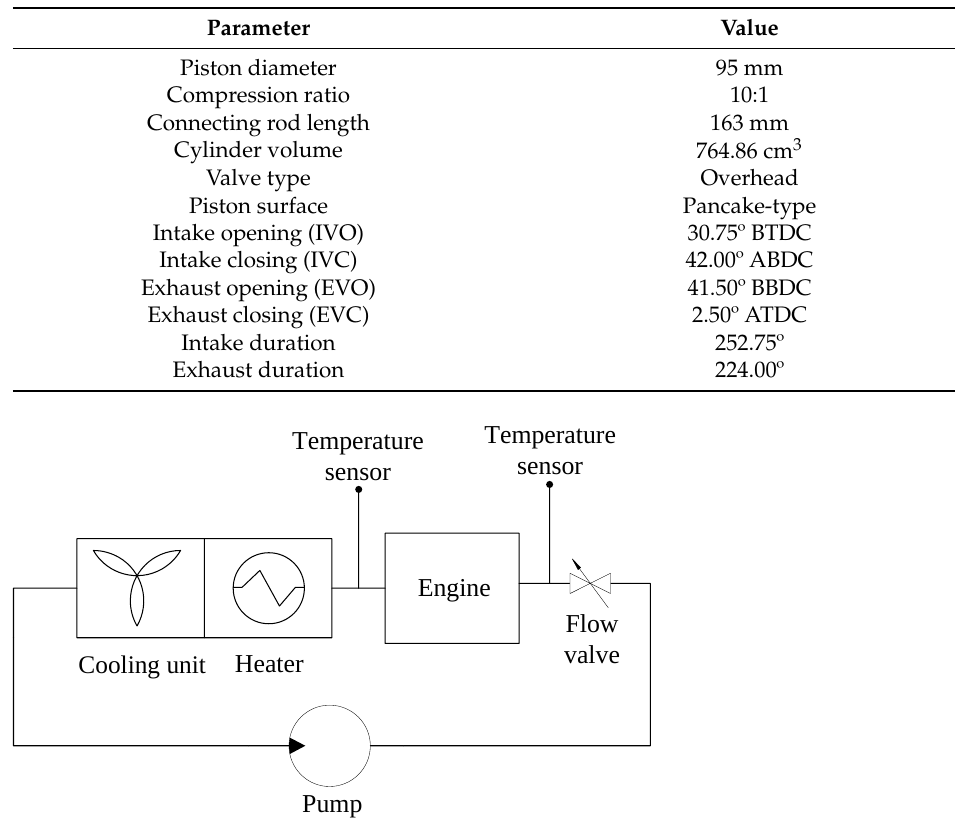
Figure 2. Engine cooling system